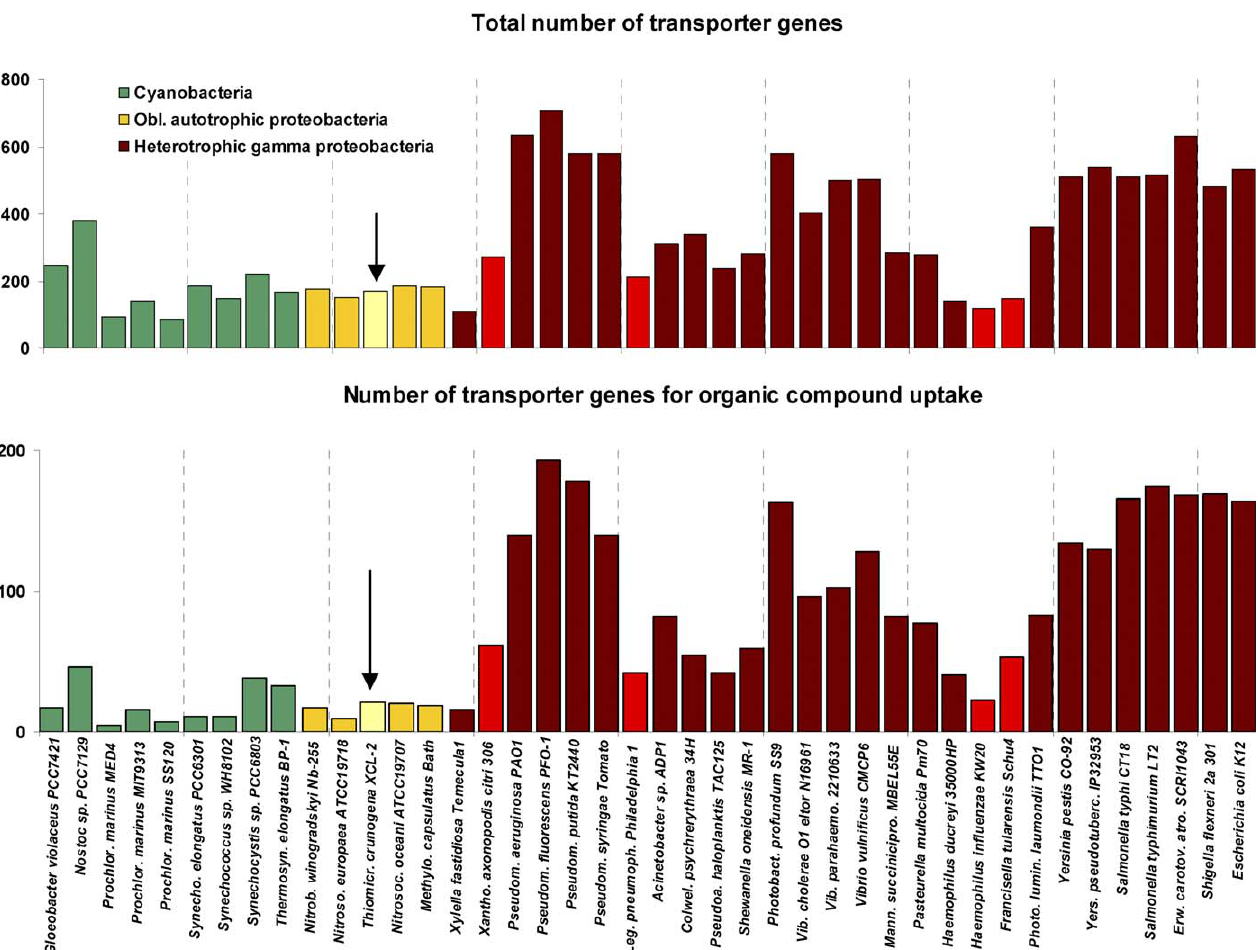
Figure 5. Transporter Gene Frequencies within the Genomes of Thiom. crunogena XCL-2 (Arrow) and Other Proteobacteria Nitrob. winogradskyi (Nitrobacter winogradskyi) is an alphaproteobacterium, Nitros. europaea (Nitrosomonas europaea) is a betaproteobacterium, and Nitrosoc. oceani (Nitrosococcus oceani) and Methylo. capsulatus (Methylococcus capsulatus) are gammaproteobacteria. Bars for intracellular pathogens are lighter red than the other heterotrophic gammaproteobacteria. DOI: 10.1371/journal.pbio.0040383.g005